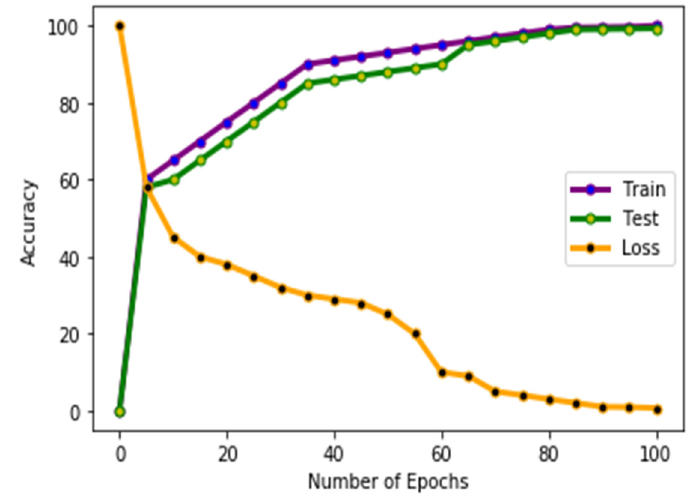
Figure 4. The training, test and loss of the DL-ac4C. Table 3. Comparison of deep learning DL-ac4C with existing models. Dataset Methods ROC Cross